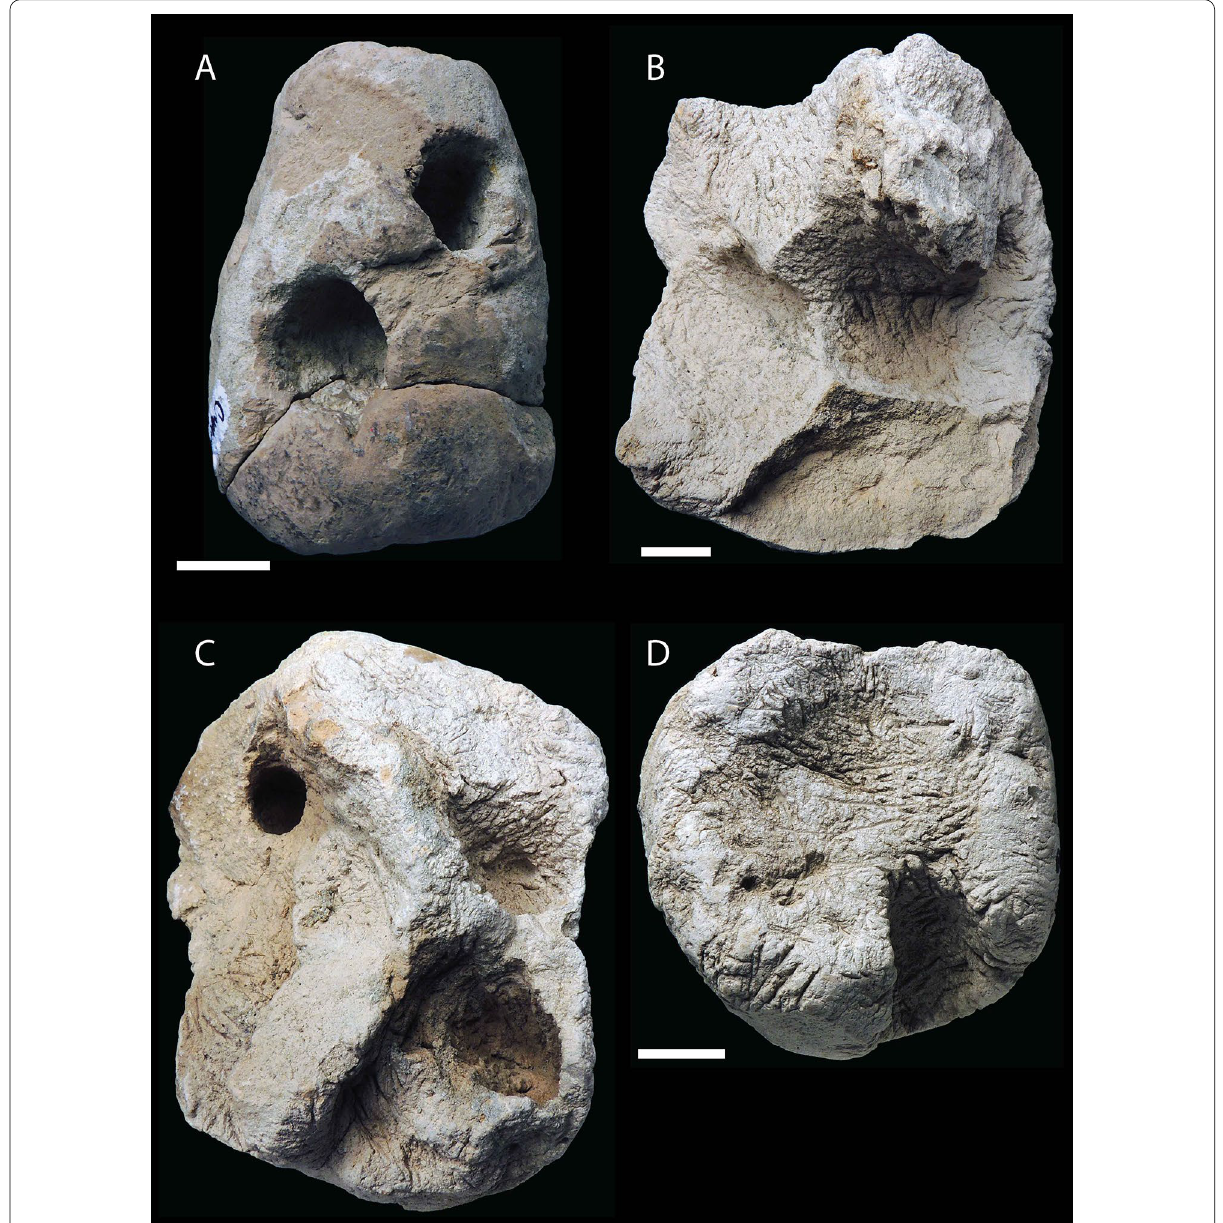
Fig. 4 Transexcrementum cuniculus igen. et isp. nov., paratypes. A CMM-V-7958, a burrowed vertebrate (probably crocodilian) coprolite from Calvert Cliffs, Maryland, U.S.A. B–D CMM-V-6500, a single vertebrate (probably crocodilian) coprolite broken in two roughly equal-sized pieces. B is a view of the heavily burrowed internal surface of one of these pieces, and C , D are two views of the other part of this same coprolite. In D , notice all the gouge marks over much of the outer surface of this portion of the coprolite. Scale bars equal 10